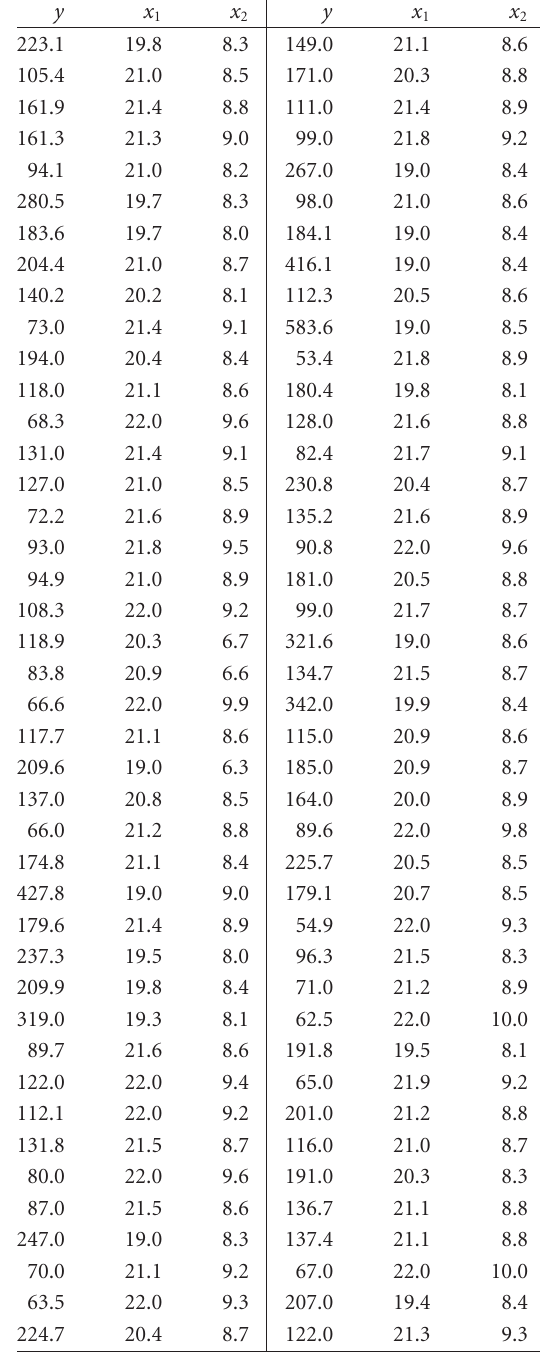
Table 1. Raw data used in simulation